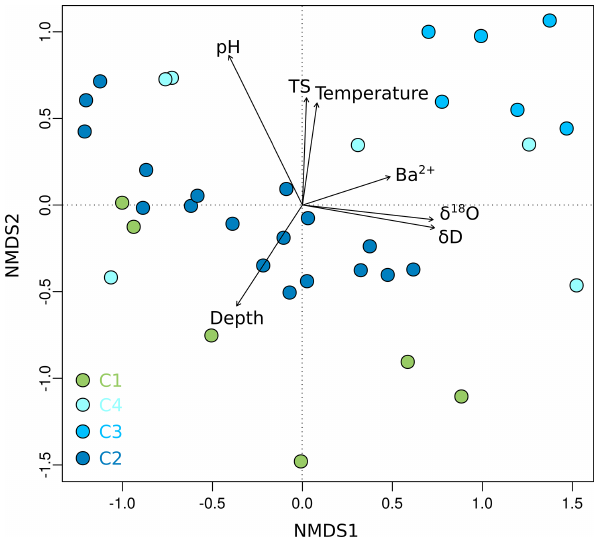
Figure 6. Non-metric multidimensional scaling (NMDS) plot of OTU 0 . 03 data from Unit II as a function of environmental param- eters. Shown are environmental factors that contribute significantly ( p <0.05) to the variance of the community data. The stress value of the NMDS plot is 0.13. Each dot represents the mean value of rel- ative OTU abundances from two technical replicates. Sample depth is denoted as metres below the surface for terrestrial samples and metres below the seafloor for submarine